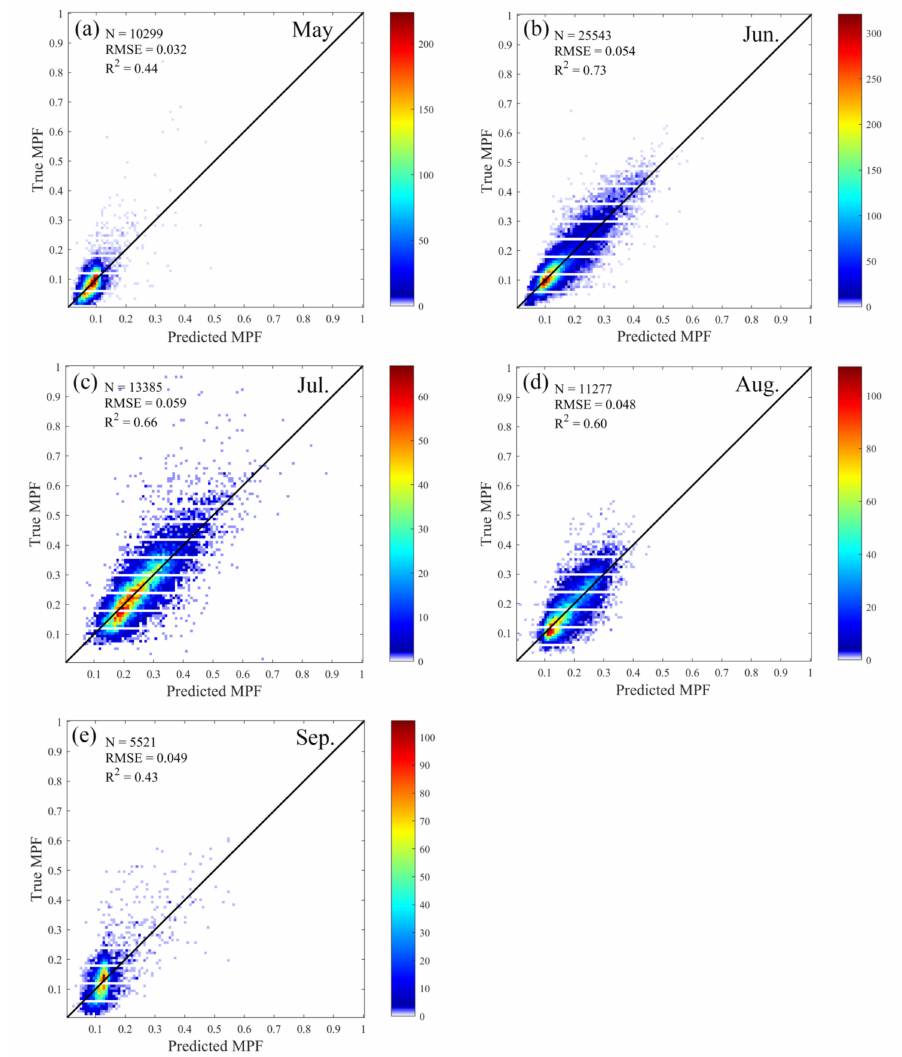
Figure 8. Performances of the GA-BPNN models for each month (from May to September):( a ) May, ( b ) June, ( c ) July, ( d ) August, and ( e ) September. The color gradient represents the density of the scatter in each